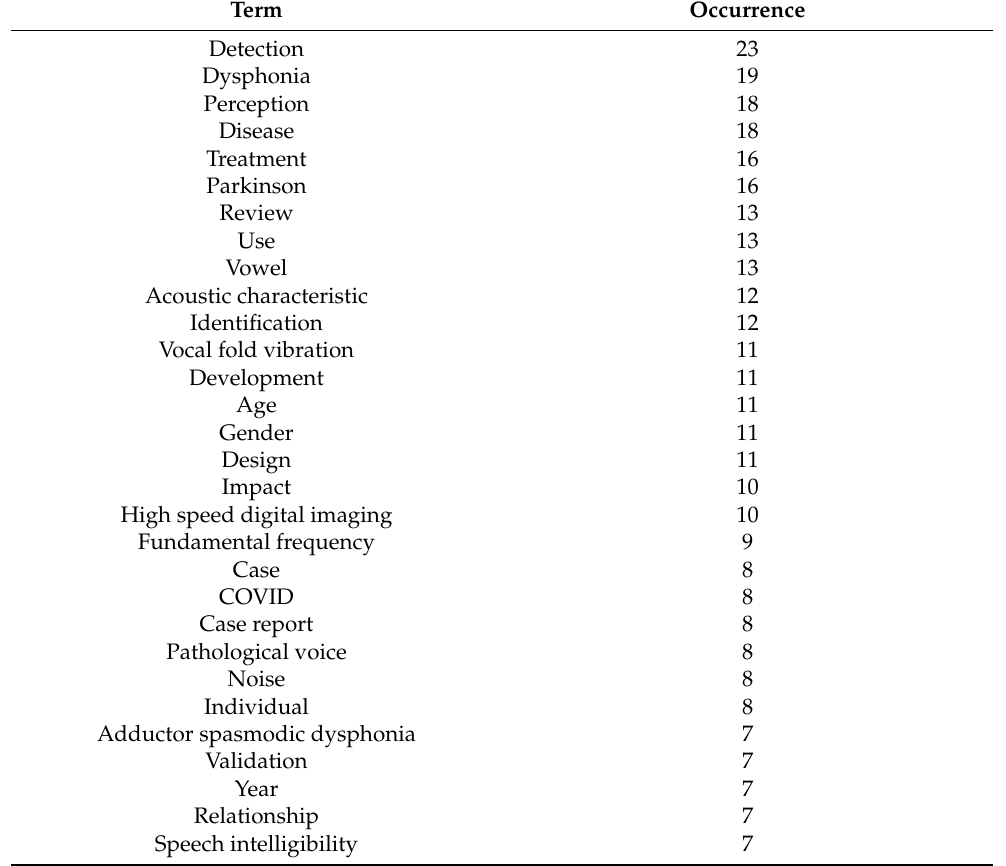
Table 3. Selected terms, level of relevance assigned by the VOSviewer software, and number of